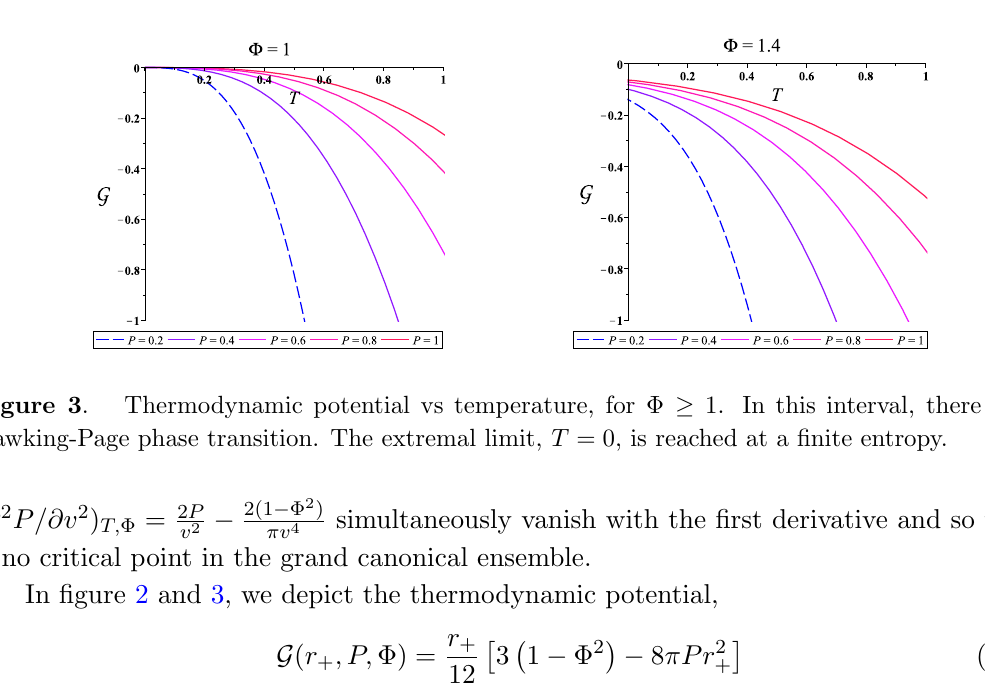
Figure 2 . Thermodynamic potential vs temperature, for (cid:8) < 1. In this interval for the conjugate potential, there is a (cid:12)rst order (Hawking-Page) phase transition for any P > 0.